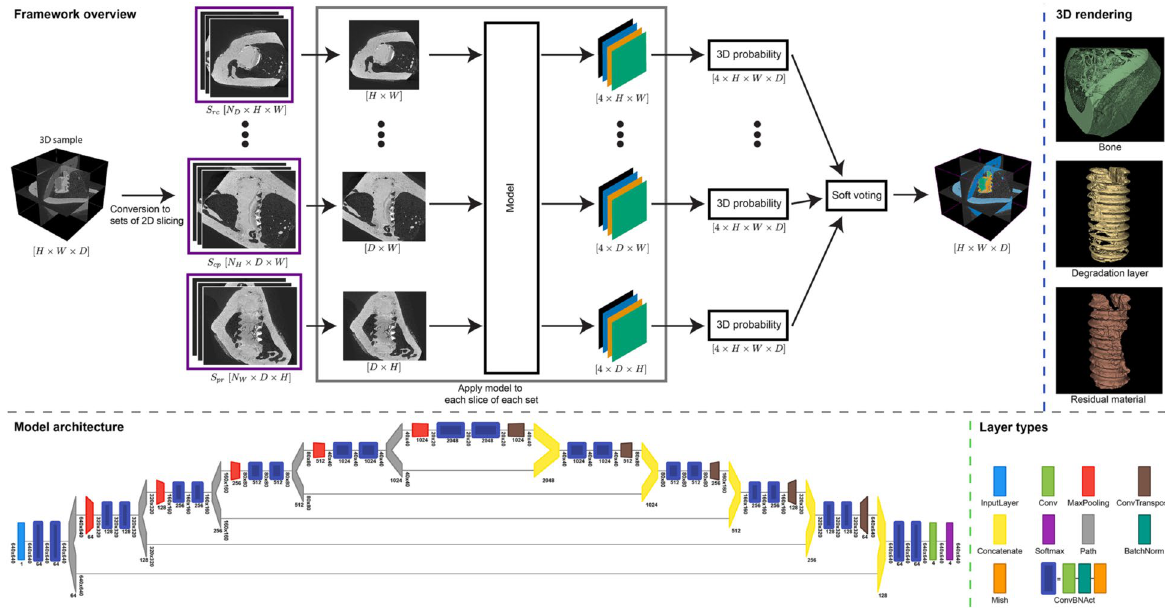
Figure 1. Overview of the segmentation framework for high-resolution synchrotron radiation microtomograms. Top shows the full segmentation pipeline: 1. conversion of 3D tomograms into 2D slices. 2. processing of slicing sets by our model. 3. soft voting is used to fuse the multi-axes prediction into the final segmentation. Top right: 3D rendering of the resulting segmentation (created with 3D Slicer, v4.11, https:// www. slicer. org/). Bottom shows our final U-net model architecture and the layer legend (created with Net2Vis 38 , https:// github. com/ viscom- ulm/ Net2V